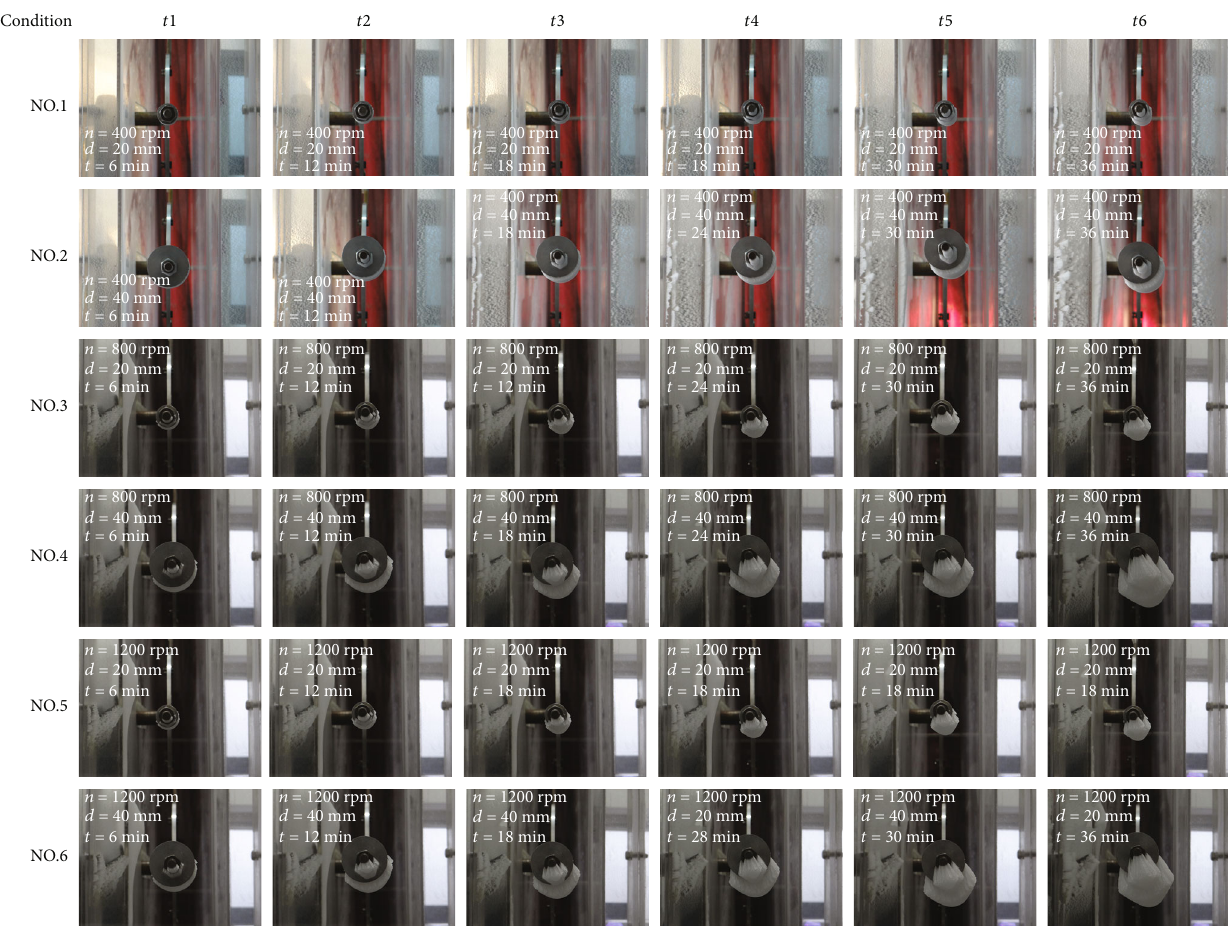
Figure 8: Images of icing distributions on surfaces of cylinders with di ff erent